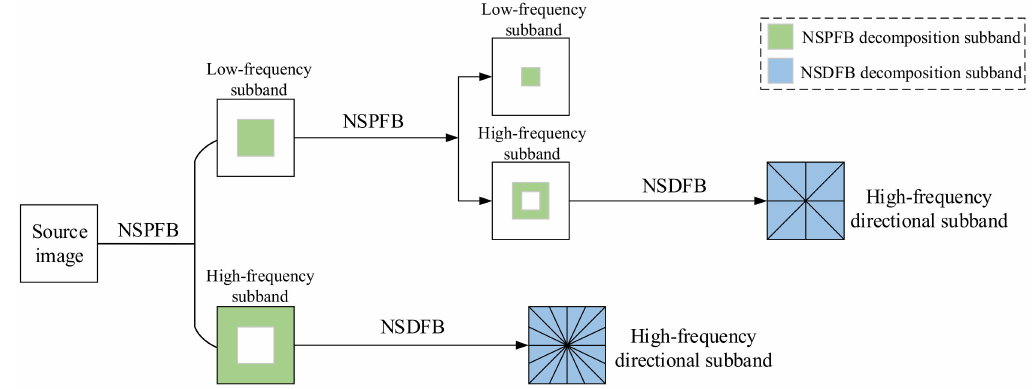
Figure 7. Structure block diagram of non-subsampled contourlet transform (NSCT)